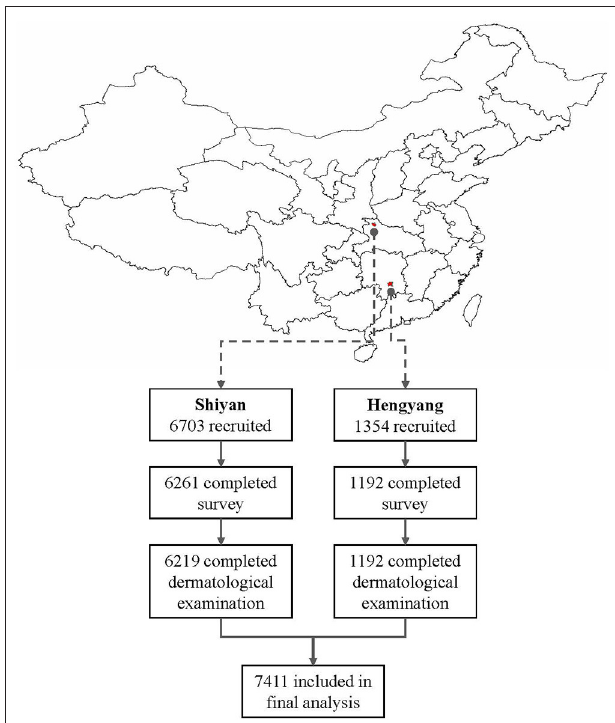
FIGURE 1 | Study sites and flowchart of inclusion of study